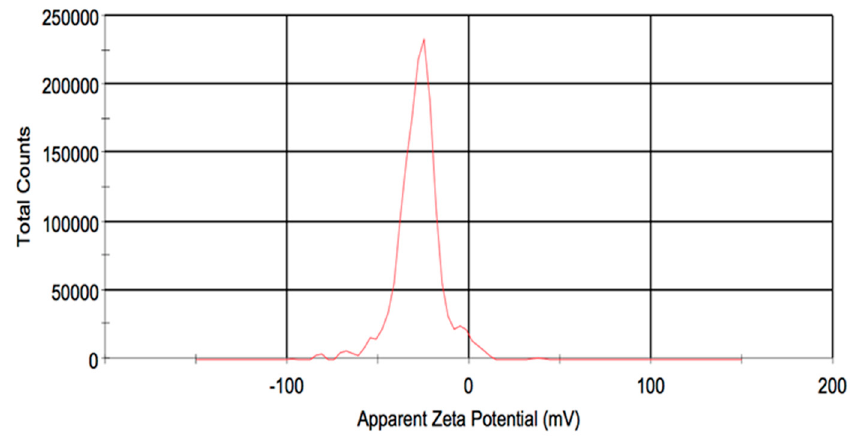
Figure 3. Surface charge distribution of Ag nanoprisms as measured by zeta potential.